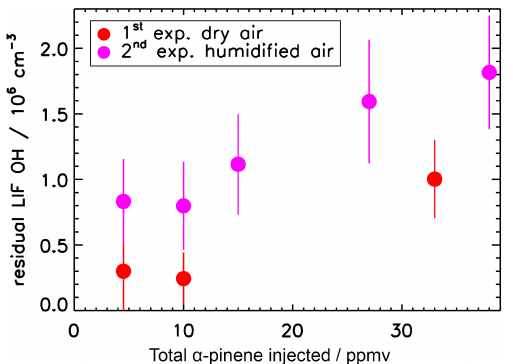
Figure 8. Residual OH signal by LIF (cell with short inlet) for each α -pinene oxidation period during two ozonolysis experiments in the SAPHIR chamber in the presence of CO as OH scavenger depend- ing on the total α -pinene that had been injected during one experi- ment. One experiment was conducted in dry air (first day) and the other in humidified air (second day). The chamber was flushed with a high flow of synthetic air overnight between the two experiments. Residual concentrations are averaged measurements over 20min before the next α -pinene injection, when most of the α -pinene had been reacted